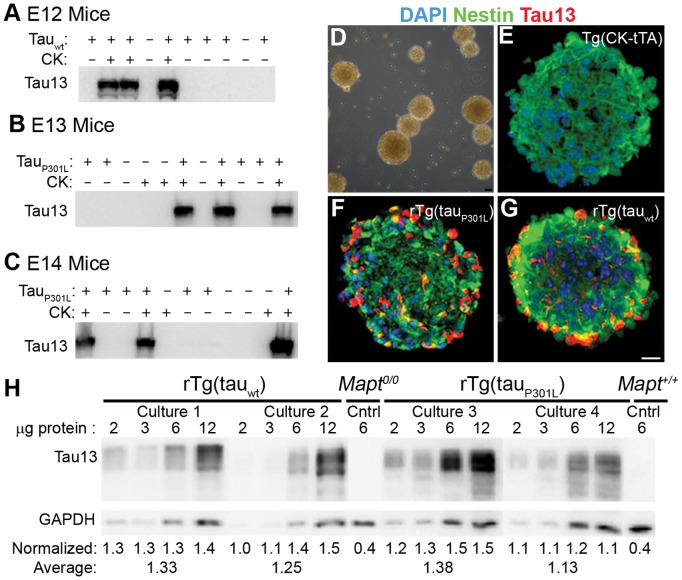
rTg(tauwt) and rTg(tauP301L) fetuses and neurospheres expressed transgene encoded human tau.(A–C) Brains were taken from Tg(CK-tTA) × TRE-tau pups at E12 (A) E13 (B) and E14 (C) for WB analysis with the human specific anti-tau antibody, Tau13. We saw immunoreactivity only in brain homogenates from pups that genotyped positive for both transgenes. None of the samples from pups with either the transactivator or responder transgene alone or with neither transgene were immunoreactive with Tau13. (D–G) Neurosphere cultures generated from E14 Tg(CK-tTA) × Tg(tau) mouse litters grew as non-adherent neurospheres and expressed human tau. (D) Representative phase contrast image of neurospheres in culture. (E–G) Fixed and cryosectioned neurospheres analyzed by fluorescence microscopy demonstrated that nearly all cells in Tg(CK-tTA) (E), rTg(tauP301L) (F), and rTg(tauwt) (G) expressed the CNS-SC protein, nestin (green). rTg(tauP301L) (F) and rTg(tauwt) (G) neurospheres contained cells that were strongly immunoreactive with Tau13 (red); control Tg(CK-tTA) (E) neurospheres did not. DAPI nuclear stain is blue in E–G. (H) Western blot analysis from two independent rTg(tauwt) neurosphere cell lines (cultures 1 and 2) and two independent rTg(tauP301L) neurosphere cell lines (cultures 3 and 4) showed comparable levels of human tau between genotypes. Tau13 immunoreactivity was normalized to GAPDH. The normalized values indicated that human tau levels were comparable between genotypes. Lysates from cultures 1 and 2 were probed together on one blot, and lysates from cultures 3 and 4 were probed together on another. Control samples expressing only endogenous mouse tau (Mapt+/+), or neither mouse nor human tau (Mapt0/0) were included on each membrane; only one set is shown here for the sake of simplicity.